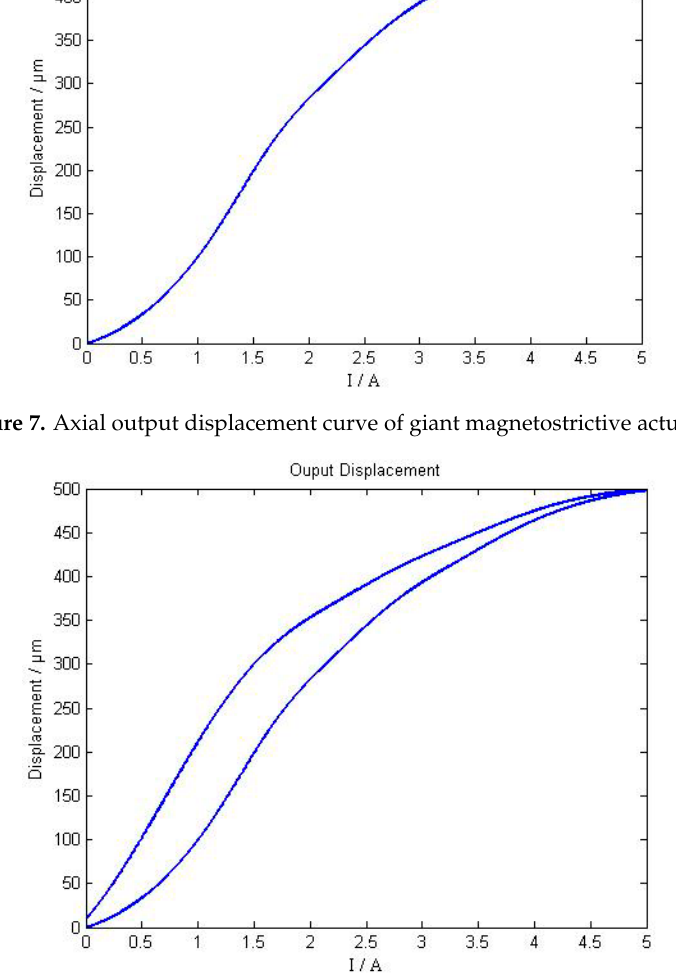
Figure 8. Hysteretic loop of a giant magnetostrictive actuator.